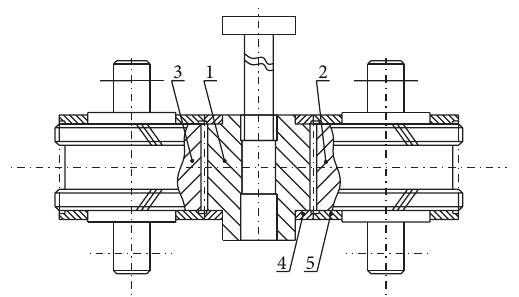
Figure 10: Structure of the spacing ring. 1: floating pinion, 2: gear, 3: gear, 4: radial spacing ring installed in floating pinion, and 5: radial spacing ring installed in gears.